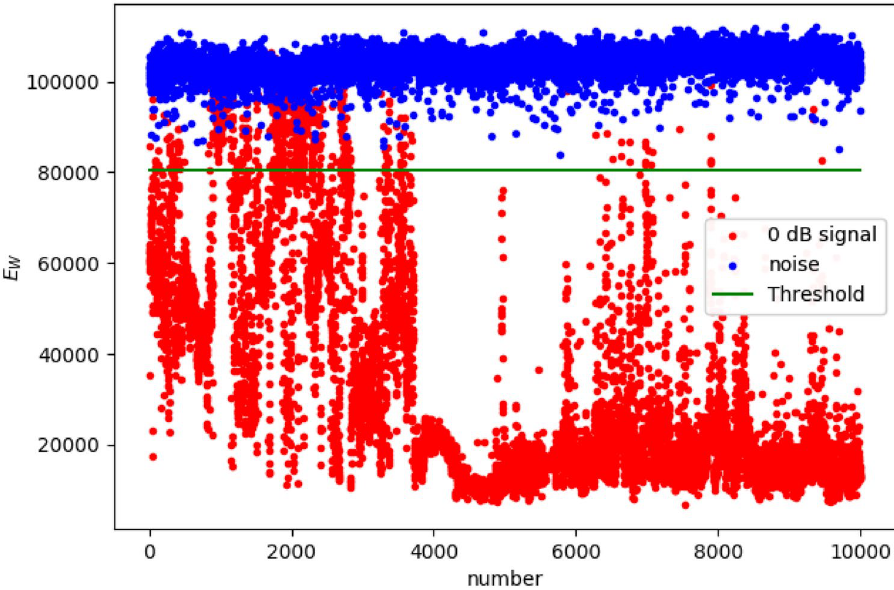
Figure 3. Weak signal detection by I/Q data weight extremes distribution method. The X-axis coordinate is expressed as E W of an I/Q sample. The E W of the noise is concentrated on a relatively high